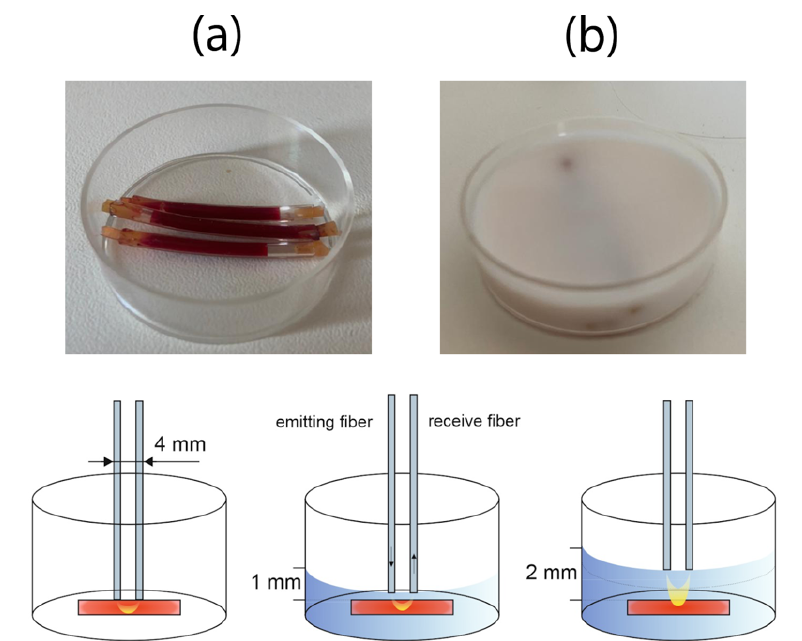
Figure 2. Measurements an optical phantom: ( a ) Before filling with a scattering medium that simulates the fatty layer of the mammary gland; ( b ) After filling with a scattering medium (intralipid). The receiving and emitting fibers were in contact with the surface of the medium above the tubes with